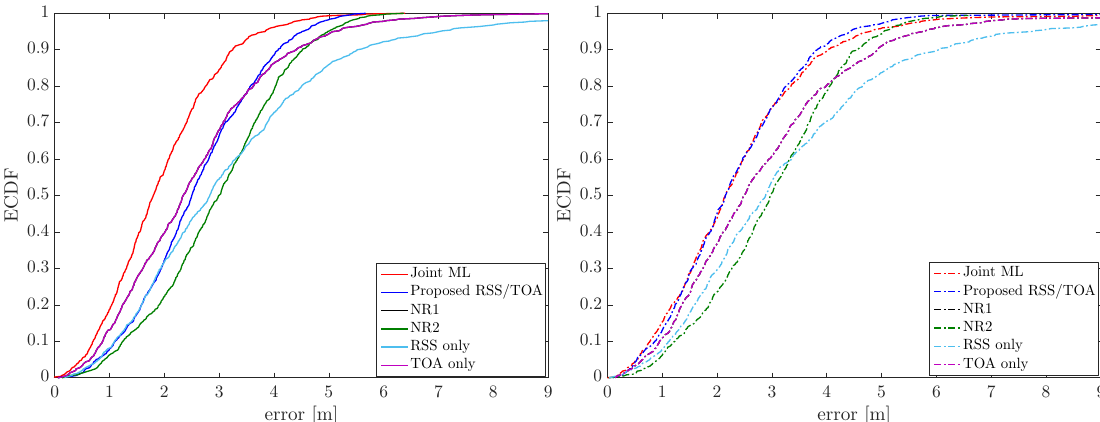
Figure 9. Empirical cumulative distribution function (ECDF) of the considered algorithms for the case α = 2, σ = 4 and N = 8. ( left ) Ideal TOA/RSS parameters and ( right ) estimated TOA/RSS parameters.